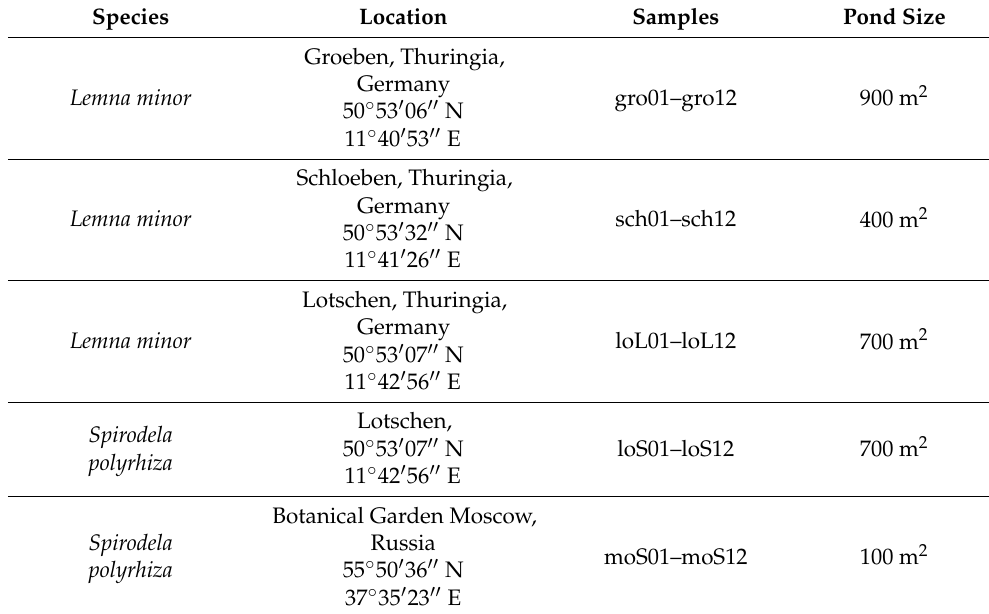
Table 3. Details of the location of ponds selected for investigation, duckweed species and samples collected. For further explanations, see Table 1. Species Location Samples Pond Size